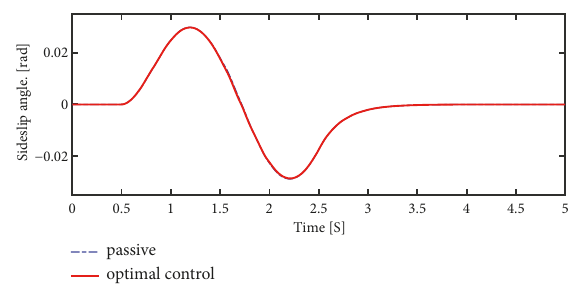
Figure 25: Sideslip